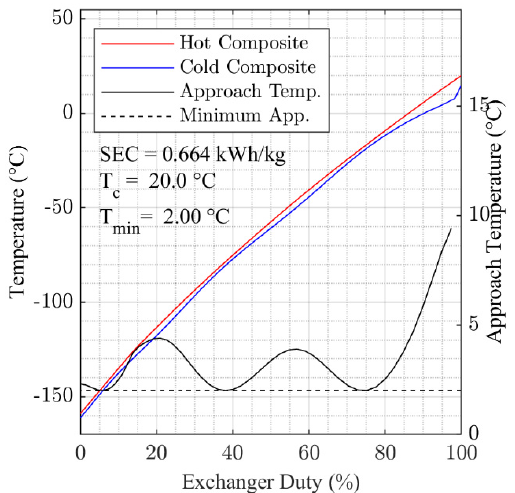
Figure A3. Optimized composite cooling curves for 15°C cooling temperature.